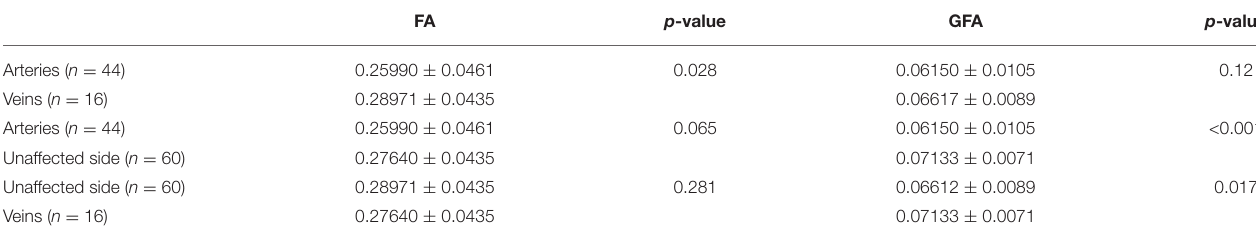
TABLE 4 | Compared responsible vessel types and the unaffected side in patients.